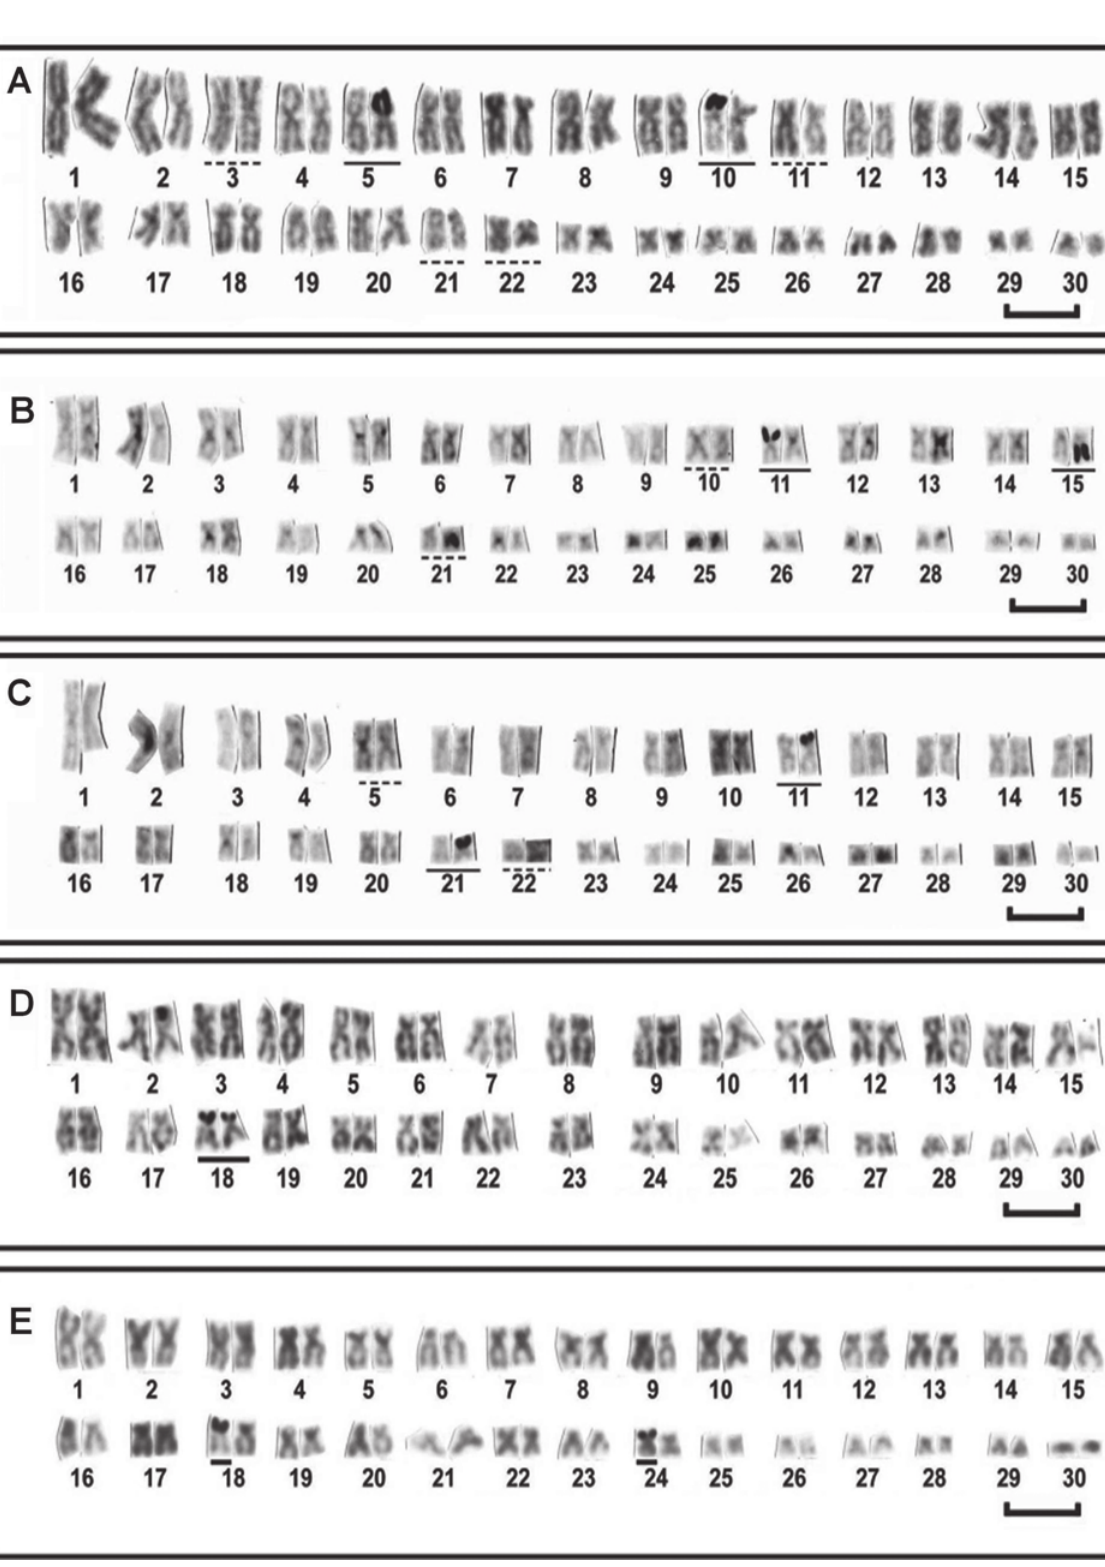
Fig. 3. Karyotypes stained with silver nitrate: (A) Symphysodon haraldi from Manacapuru; (B) S. aequifasciatus from Tefé (cytotype 1); (C) S. aequifasciatus from Tefé (cytotype 2); (D) S. discus from Barcelos (cytotype 1); (E) S. discus from Barcelos (cytotype 2). The underlined pairs are involved with the NORs. Scale bar represents 5